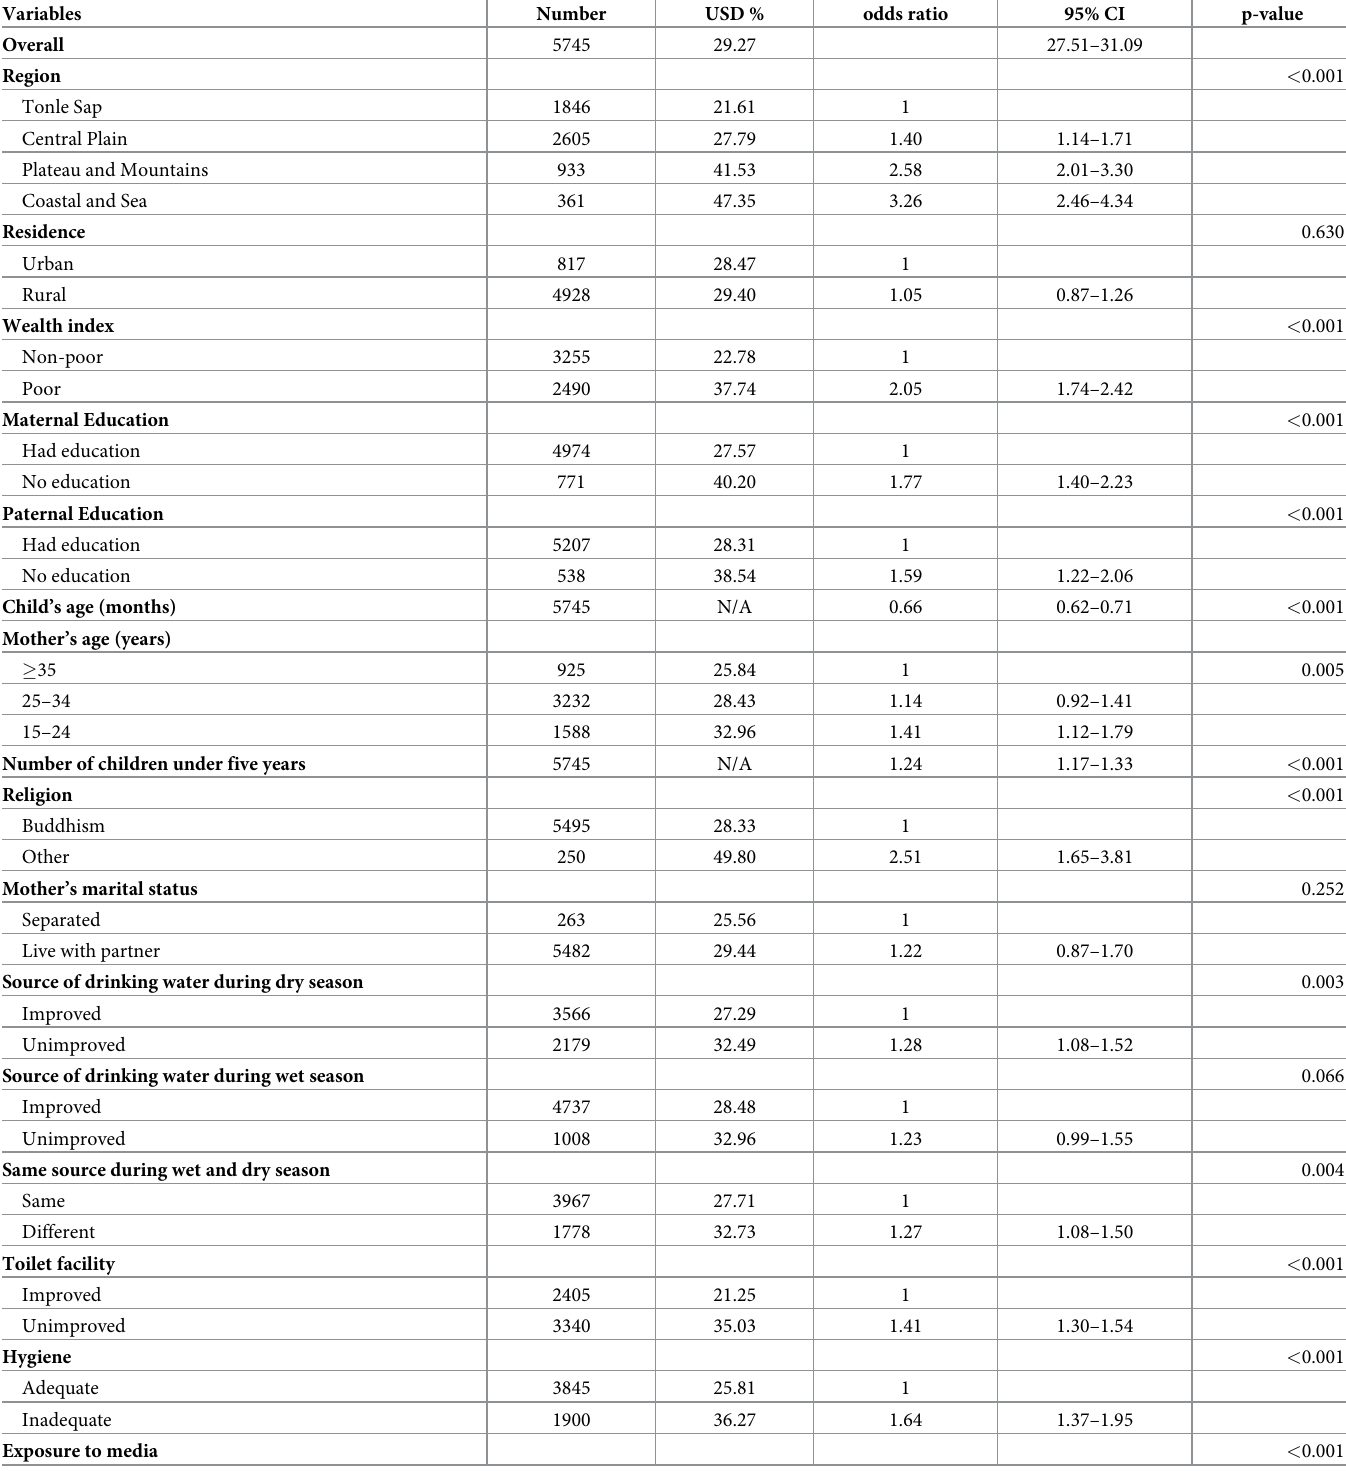
Table 2. Unadjusted binary logistic regression of factors associated with unhygienic stool disposal (USD) of children under the age of five in Cambodia, 2014 (n =